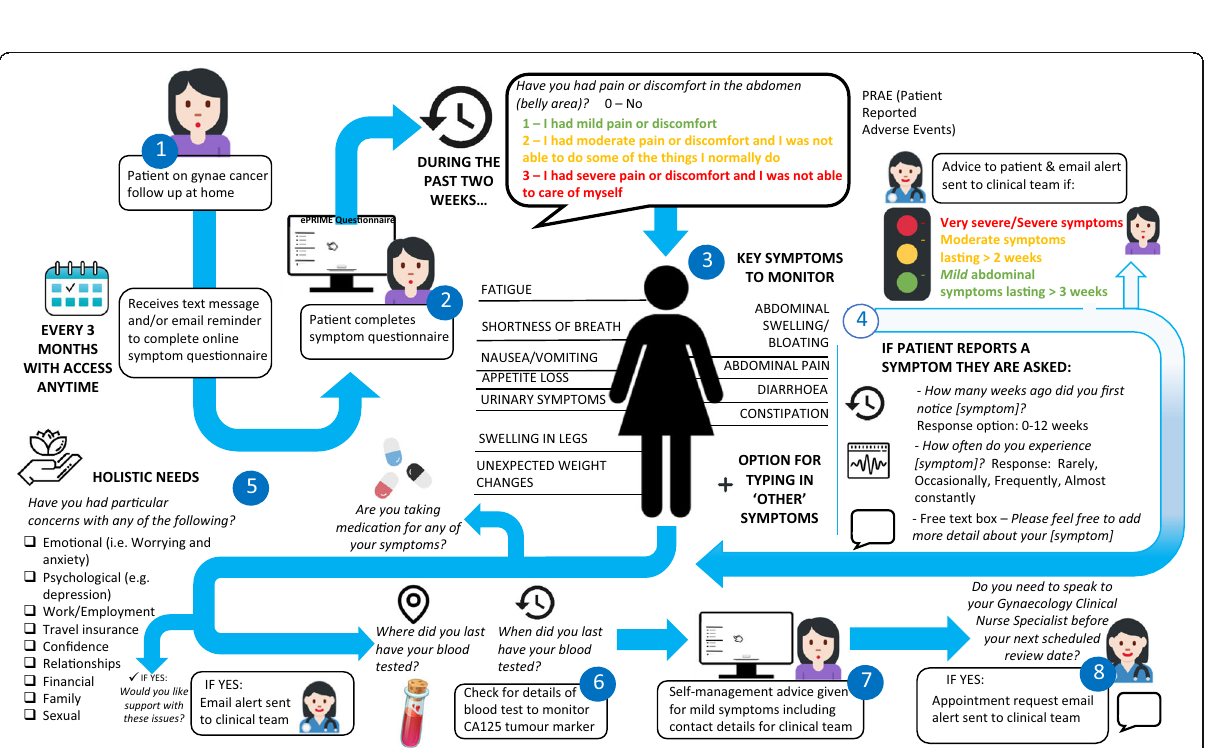
Fig. 2 Overview of the final symptom monitoring